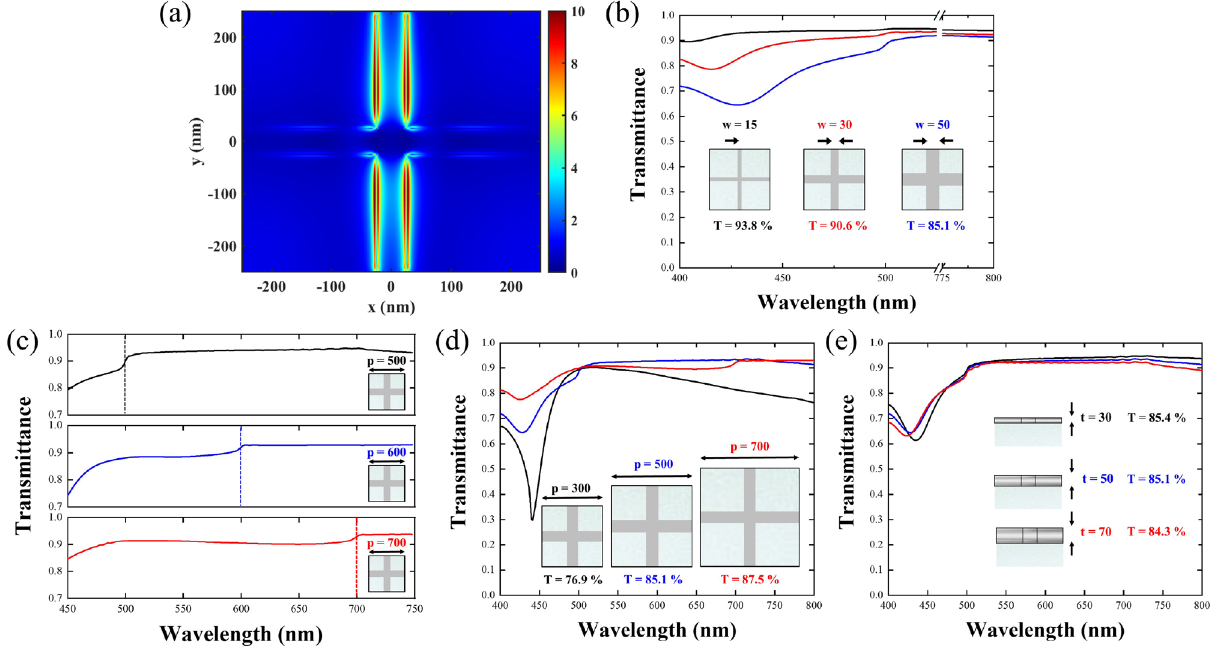
Figure 3. ( a ) Electric field distribution of the Ag NPWs at the wavelength of 430 nm. The field is mainly concentrated on the side-wall of the metallic wires, suggesting excitation of localized surface plasmon along the width of the wires. ( b ) Transmittance spectrum of the Ag NPWs with wire widths of 15, 30, and 50 nm. The dips shifted to a lower wavelength when the width shrinks. ( c ) Transmittance spectra of the silver plasmonic wires with periodicities of 500, 600, and 700 nm, respectively. Diffraction occurs at wavelengths of approximately 500, 600, and 700 nm. ( d ) Transmittance spectra with periodicities of 300, 500, and 700 nm, suggesting that by manipulating the periodicity, we could remove the diffraction from the spectrum. ( e ) Transmittance spectrum of the Ag NPWs with a metal thickness of 30, 50, and 70 nm. Thinner metals reveal higher transmittance.